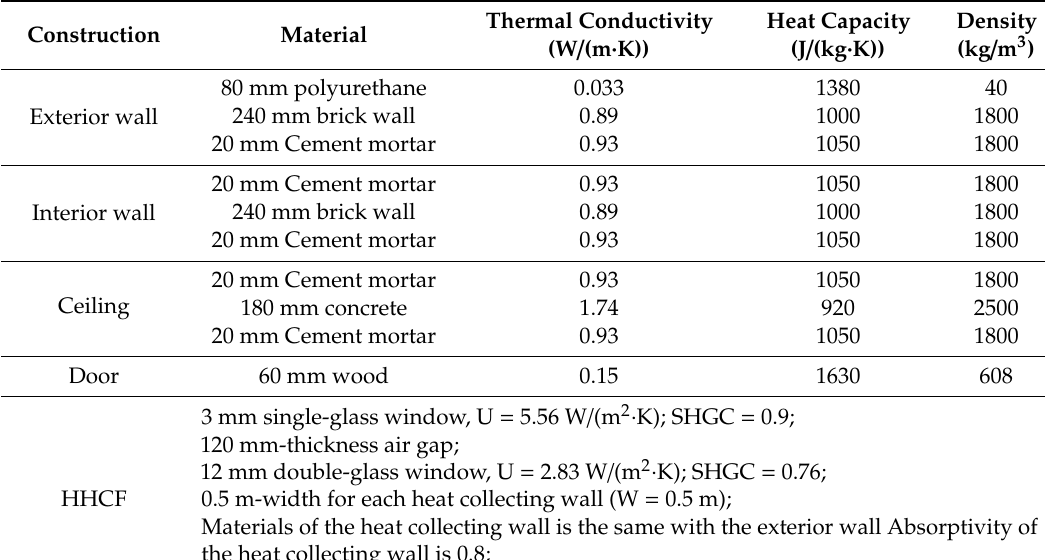
Figure 6. Geometry of the room studied. Table 1. Constructions of the